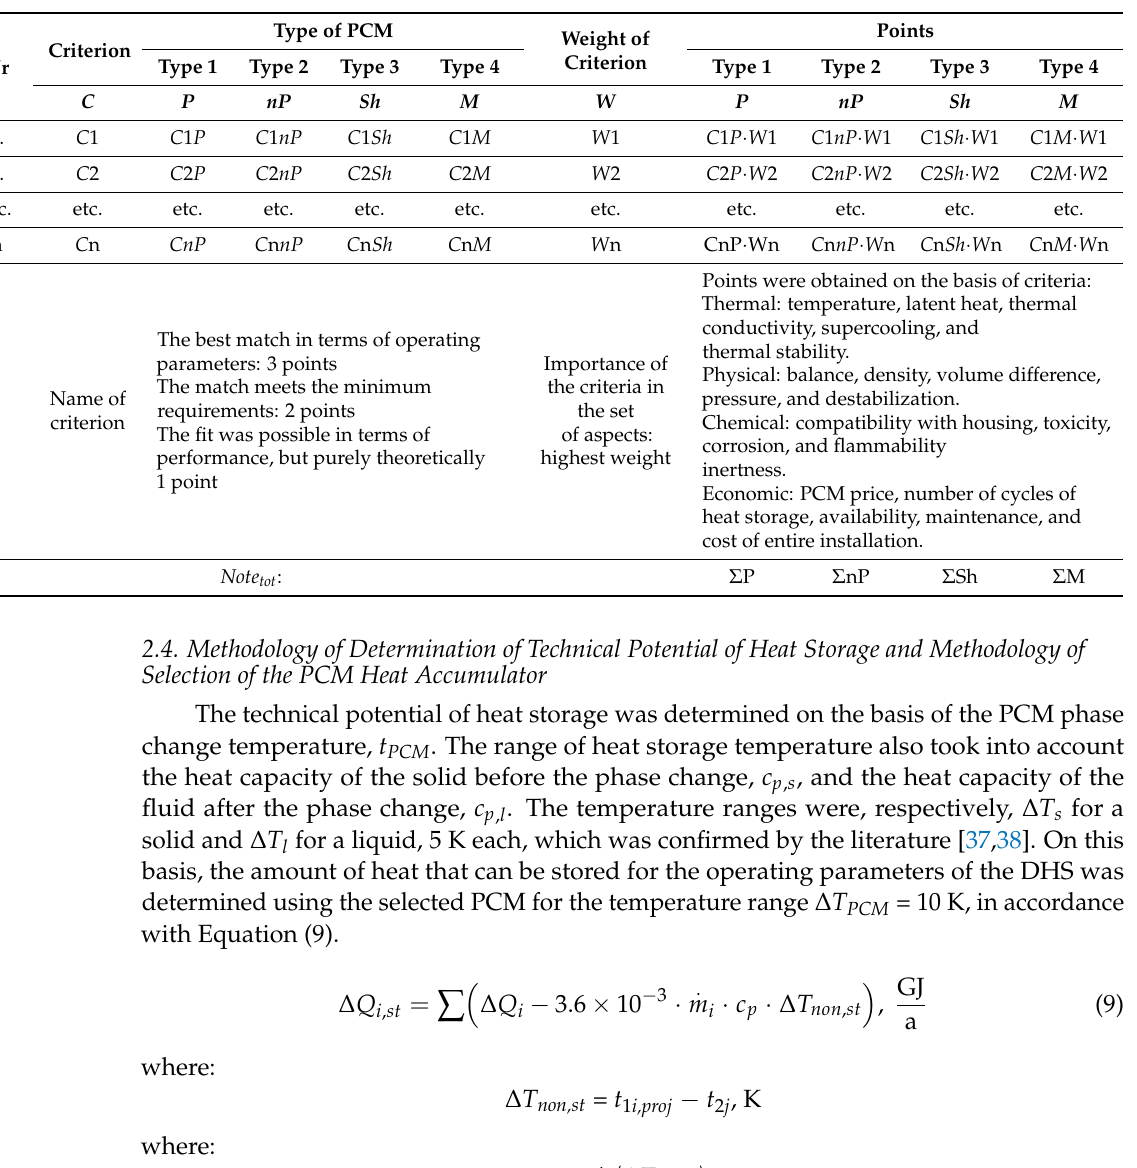
Table 1. Methodology of PCM